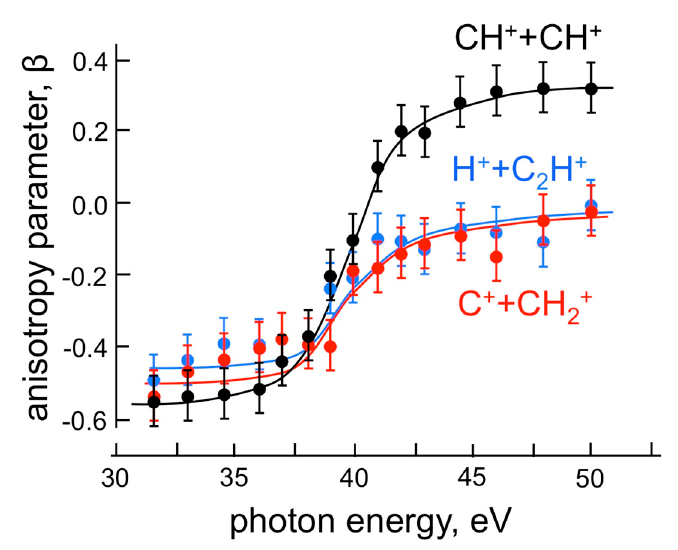
Figure 2. Photon energy dependence of the β anisotropy parameter (see Equation (4)) for each two-body fragment ion coming out from the Coulomb explosion of the C 2 H 22+ molecular dication (see reactions 1–3), as measured at a 31.9–50.0 eV photon energy